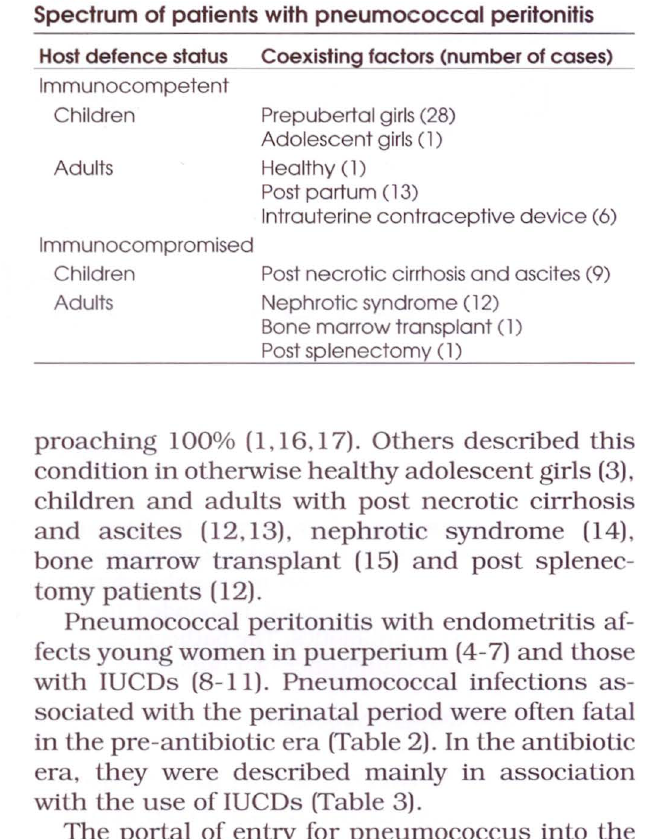
Spectrum of patients with pneumococcal